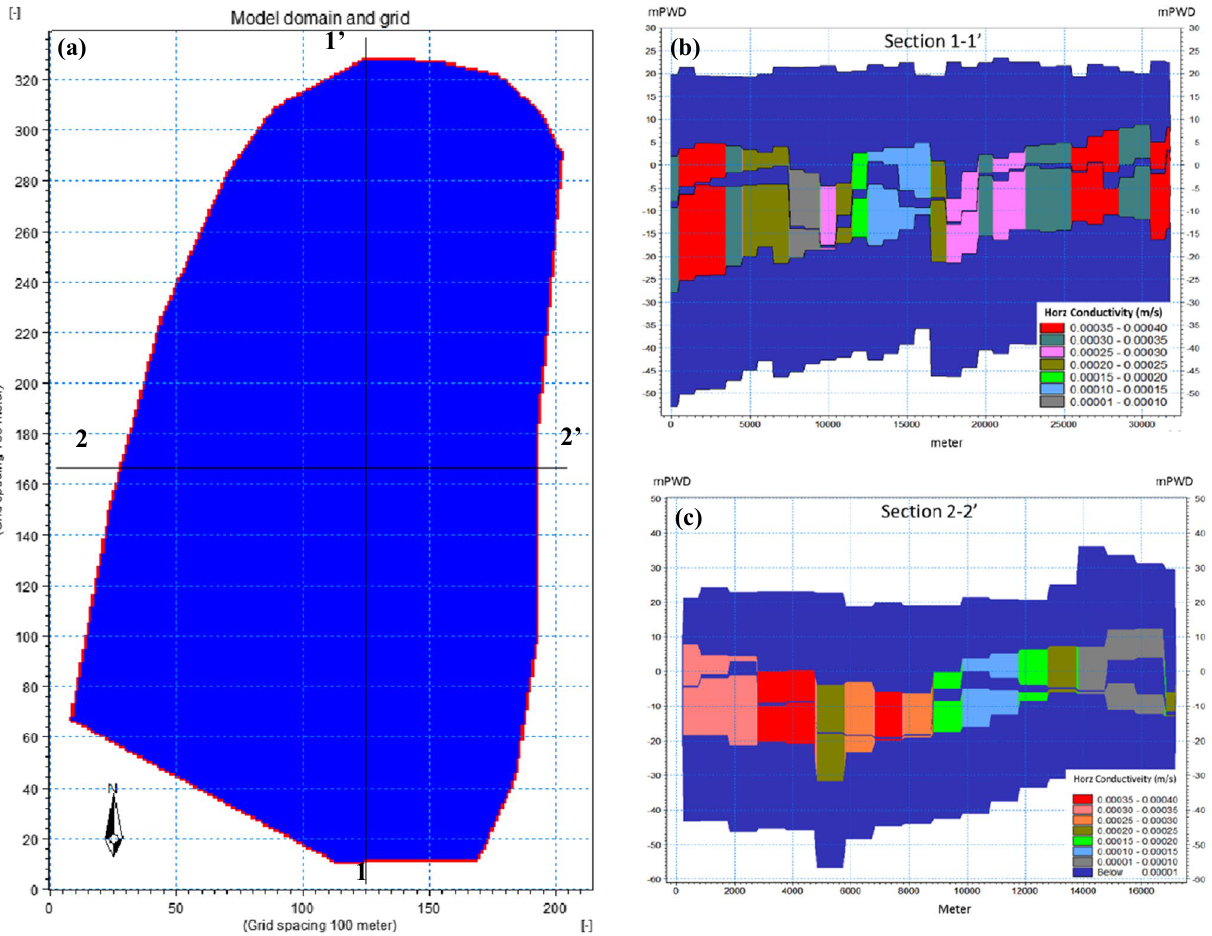
Fig. 7 a The groundwater model domain in MIKE SHE with 100 m grid, b vertical discretization of the model domain along cross section 1–1 ′ , and c vertical discretization of the model domain along cross section 2–2